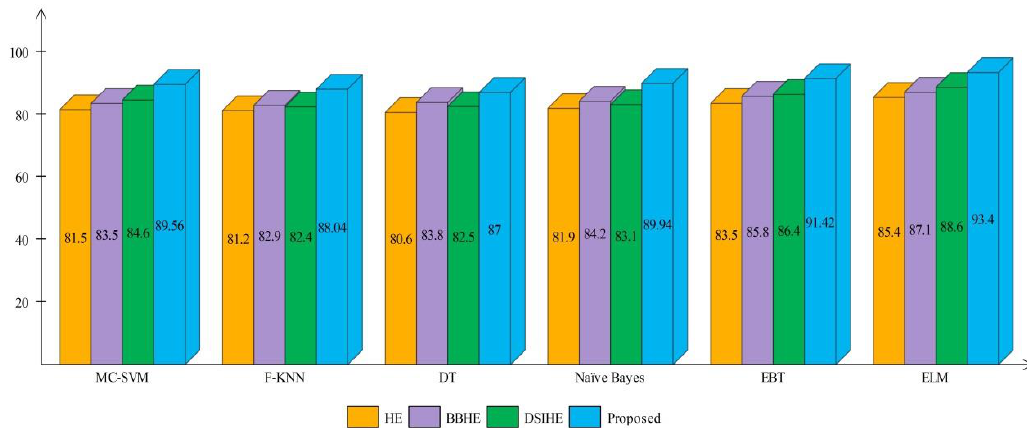
Figure 16. Comparison of different contrast enhancement techniques for HAM10000 dataset .